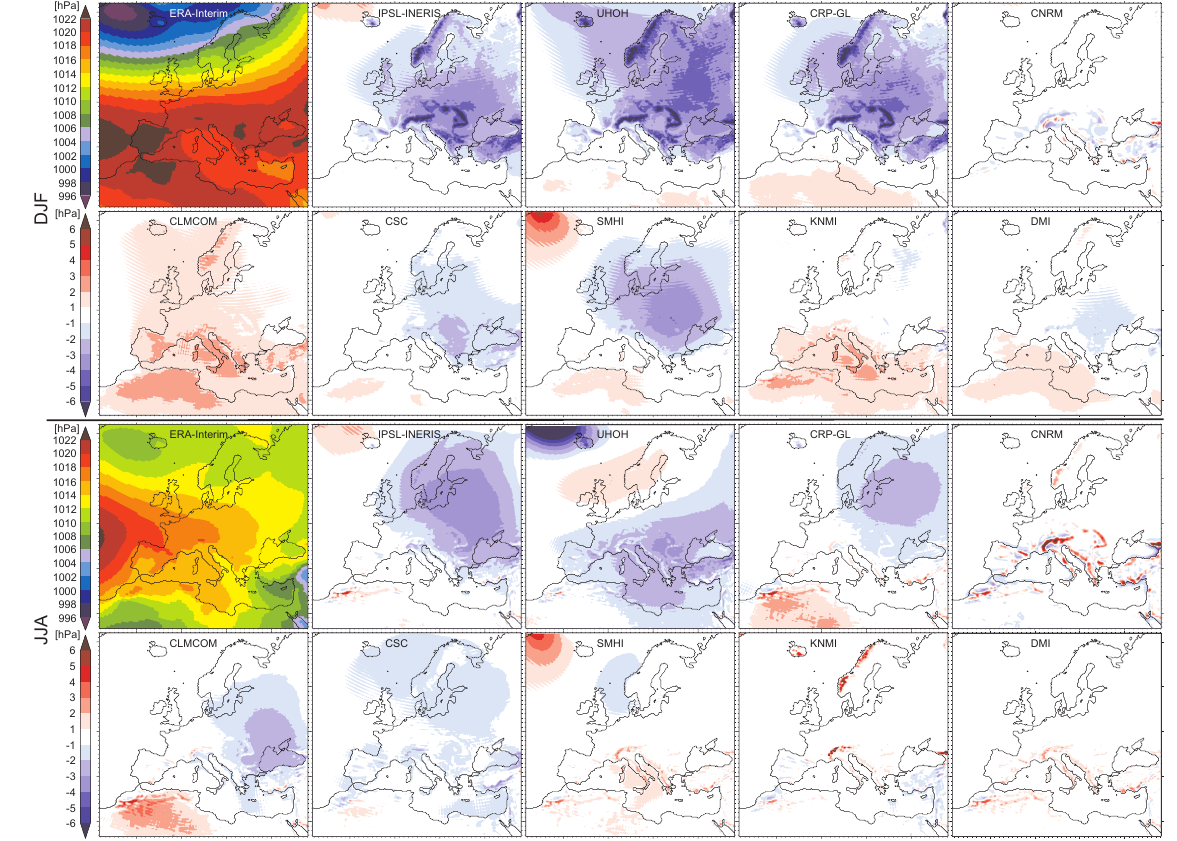
Figure 4. As Fig. 2 but for the mean seasonal mean sea-level pressure bias (hPa). The upper-left panel of each section shows the horizontal pattern of mean seasonal precipitation as provided by the ERA-Interim reference